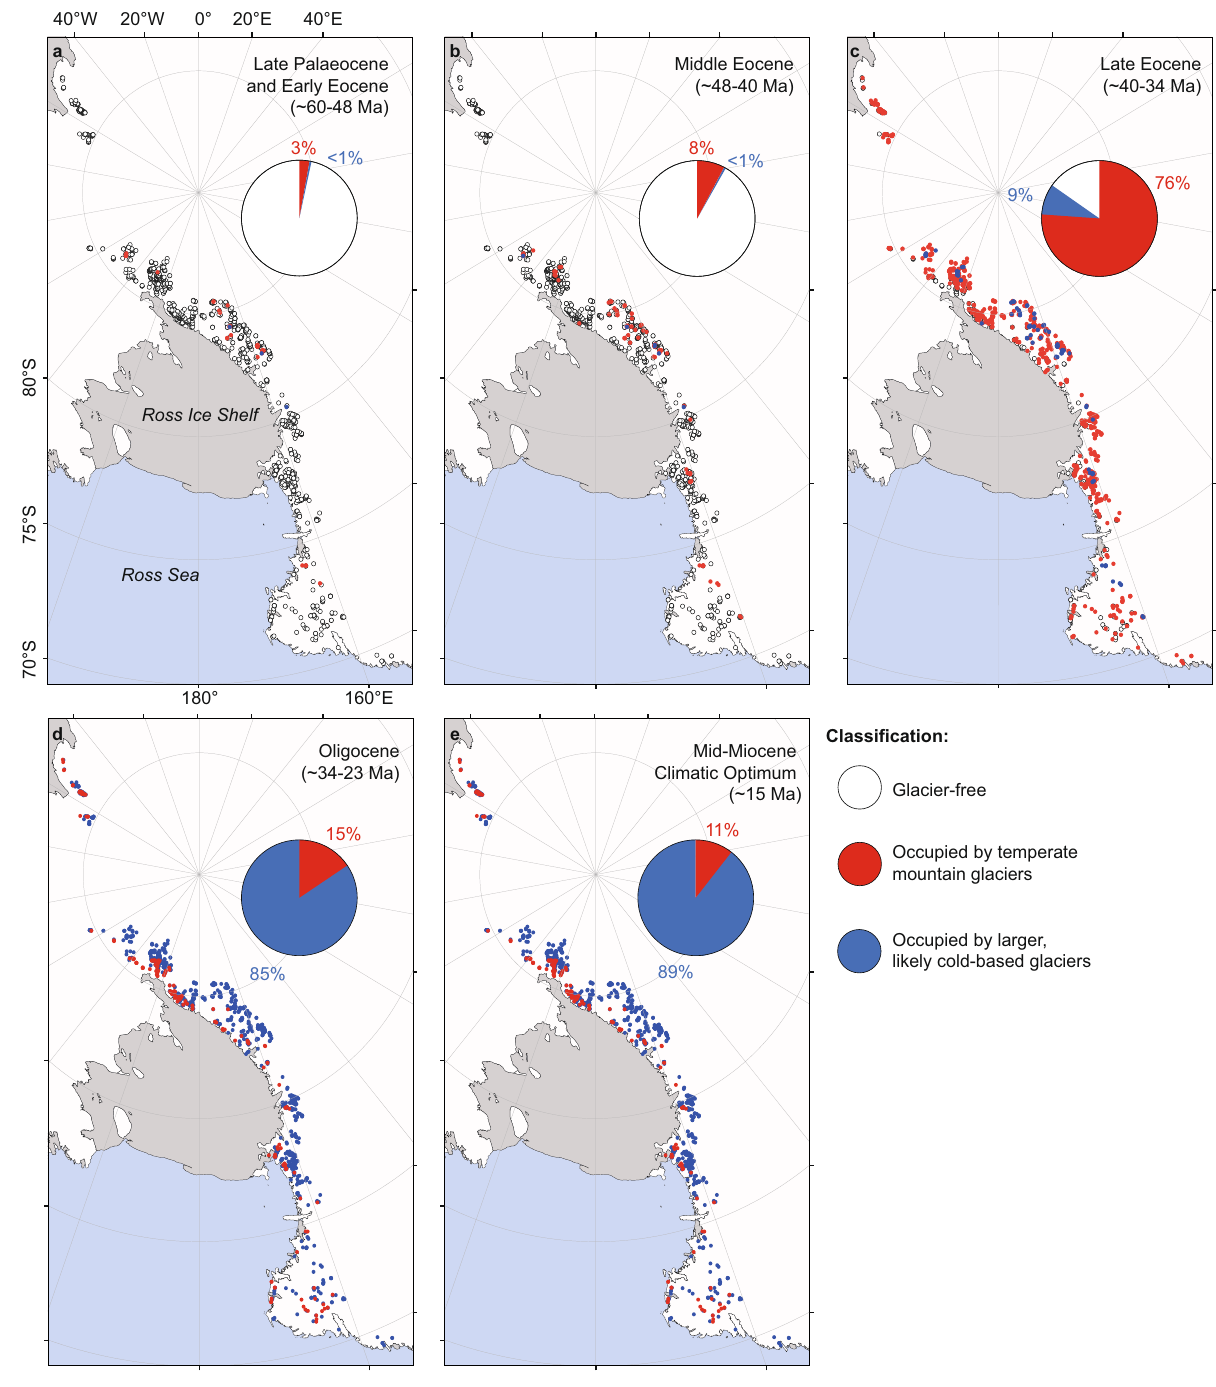
Fig. 2 | Glacier-free cirques in the Transantarctic Mountains are classi fi ed accordingtotheirglacialstatusduringvariousperiodsoftheCenozoic.a – e Pie chartsshowthepercentageofcirquesclassi fi edasglacierfree(white),occupiedby temperate mountain glaciers (red %), and occupied by larger, likely cold-based